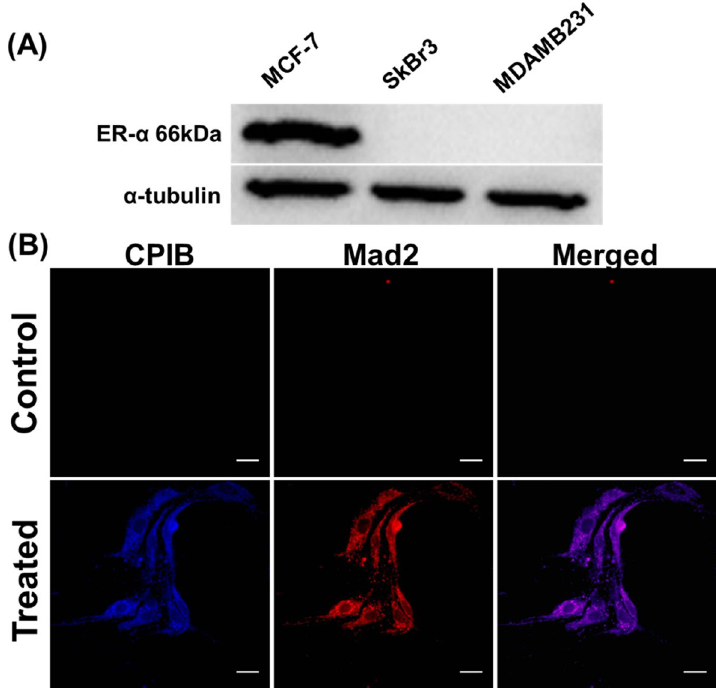
Figure 5. Immunoblotting of estrogen receptor α and immunocytochemistry of MAD2 expression. ( A ) Immunoblotting analysis of cell lysates collected from MCF-7, SkBr3 and MDAMB231 cells. Expression of ER-α was assayed in these cell lines whereas α-tubulin was used for loading control. Original blots/gels are presented in Supplementary Fig. 16. ( B ) Expression of MAD2 is higher after treatment of CPIB whereas control treatment shows no significant activation of the checkpoint protein. Scale bars correspond to 20